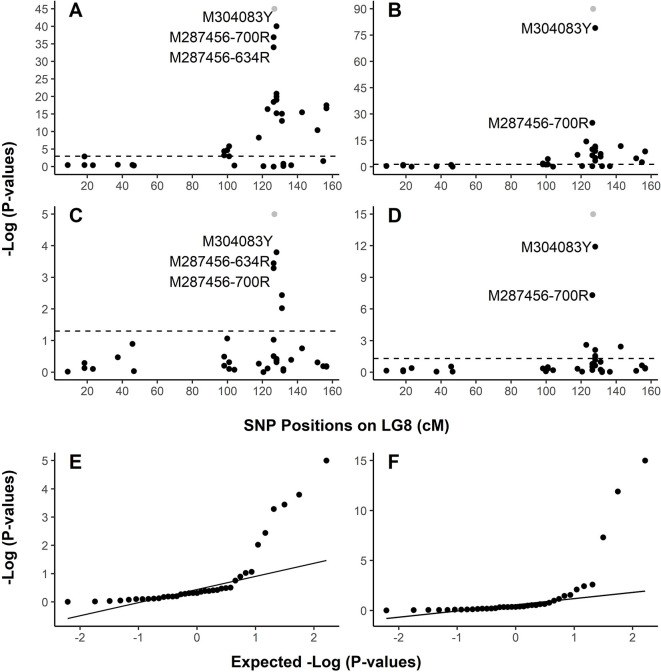
Graphical representation of test results showing strong association of SNPs with resistance to Cronartium ribicola. The Manhattan plots for resistance show –log10 p-values from linkage group 8 (LG8)-wide scan in Alberta seed families plotted against positions around the putative Cr4 locus. The x-axis represents SNP locations (cM) on LG8, and the y-axis represents −log10 p-values from genotypic associations with the resistance phenotype. The dash lines mark the threshold of p-values in Manhattan plotting. (A) Association test using GLM with family PB #2; (B) Association test using GLM with all samples of four Alberta seed families; (C) Association test using MLM with family PB #2; (D) Association test using MLM with all samples of four Alberta seed families. Quantile-quantile (Q-Q) plots showing the enrichment of association signals with observed p-values against the expected distribution under the null hypothesis. In the Manhattan plots (A–D), Cr4 was included in grey dots to show its position on LG8. LG8 was updated by integrating genetic maps described previously (Liu et al., 2016; Liu et al., 2019). (E) Q-Q plot showing results of MLM run using family PB #2. (F) Q-Q plot showing results of MLM run using all samples of four Alberta seed families.